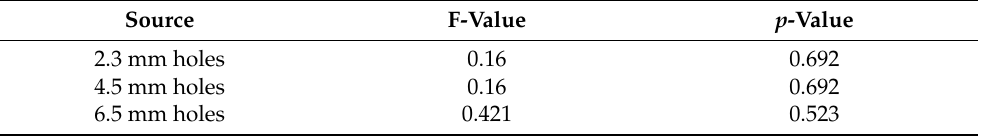
Table 7. One-way ANOVA results for holes diameter before and after the medical